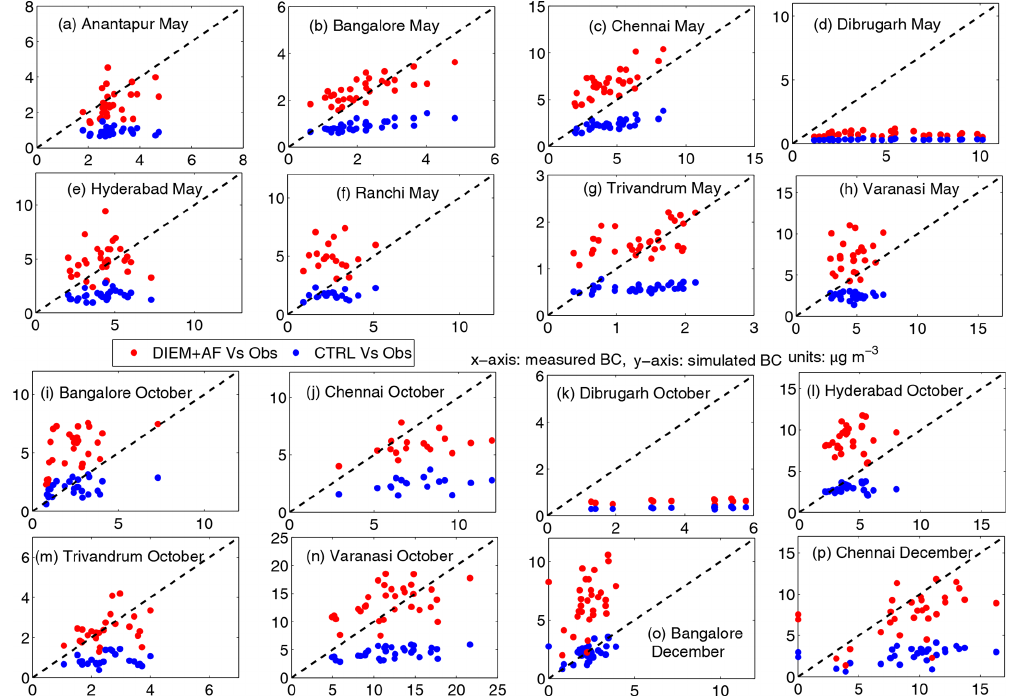
Figure 3. Comparison between the observed daily-mean NSBC and the model-simulated NSBC in the CTRL and DIEM+AF configurations, for the months of May, October and December 2011, over the different ARFI observational stations across the country. The blue dots represent the comparison between the observations and the model simulation in the CTRL configuration, while the red dots represent such comparison for the DIEM+AF configuration. The dotted black line is the 45 ◦ line representing the y = x